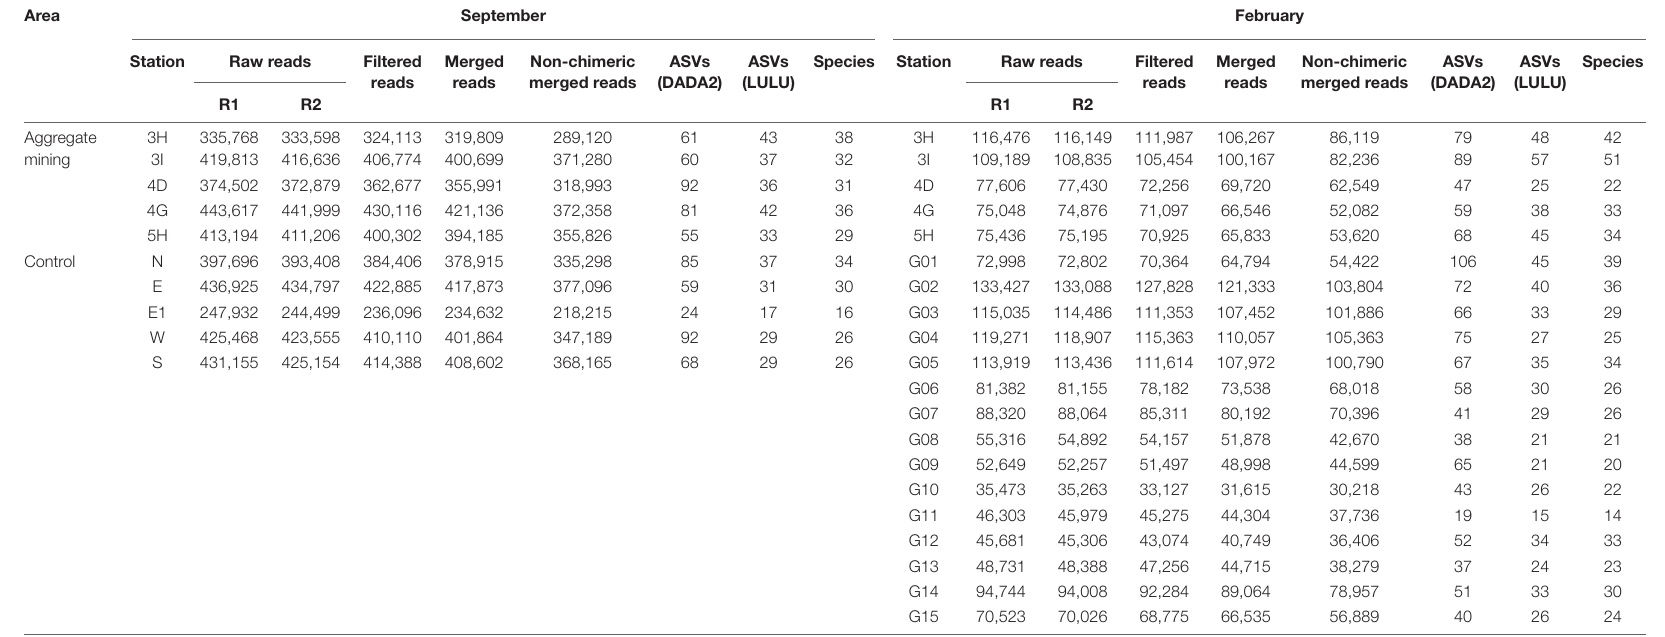
TABLE 2 | Summary of taxonomic assignment of fish reads in Korean coastal